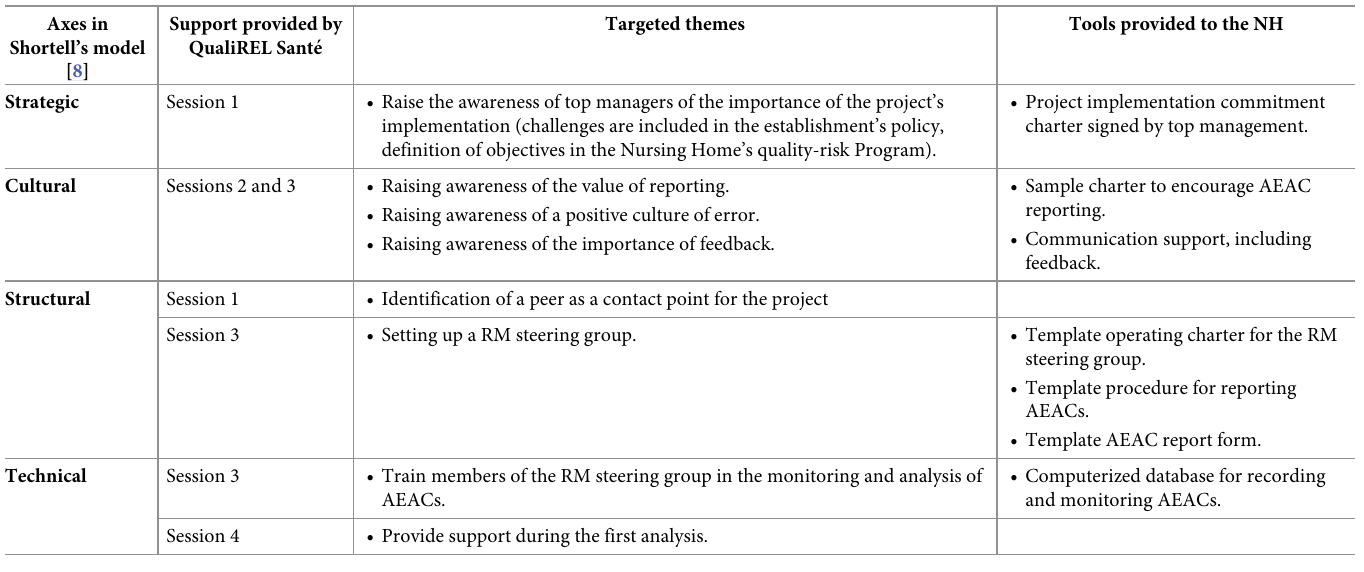
Table 1. Presentation of the training package categorized according to the 4 axes in Shortell’s